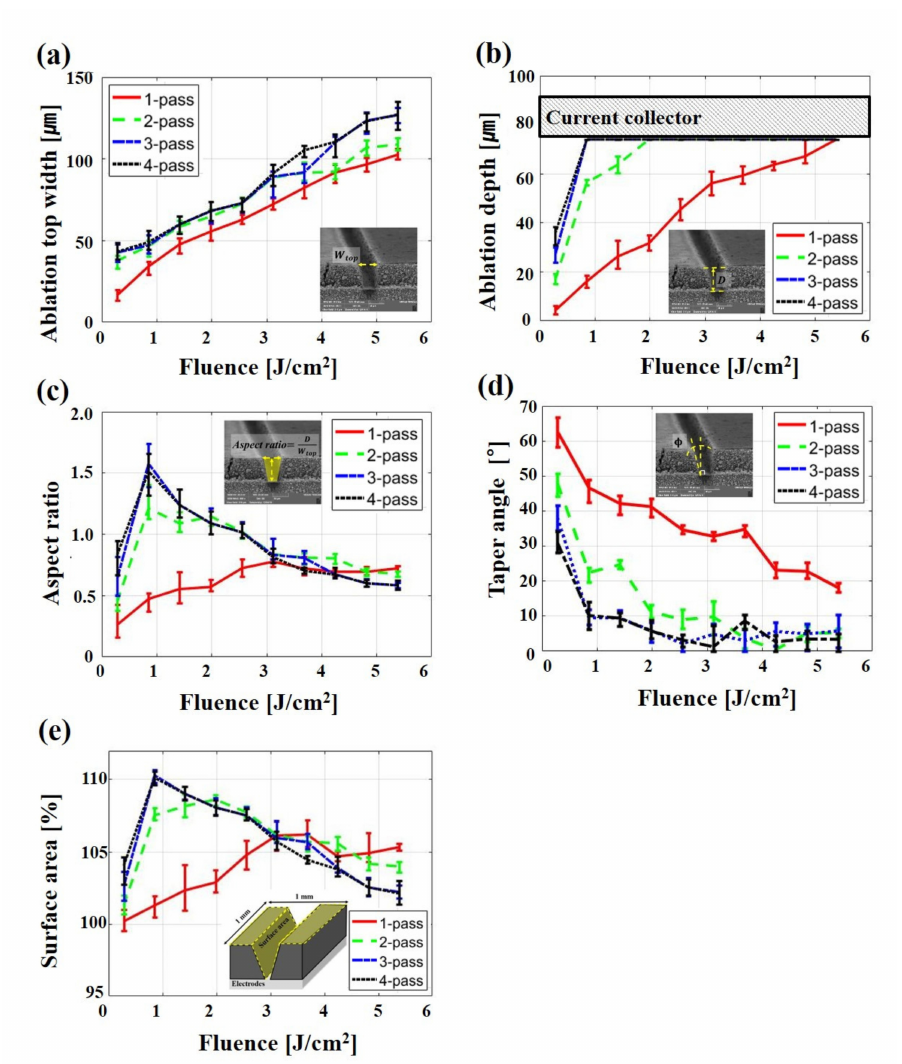
Figure 4. The variation of ( a ) ablation top width, ( b ) ablation depth, ( c ) aspect ratio, ( d ) taper angle, ( e ) surface area depending on fluence and the number of